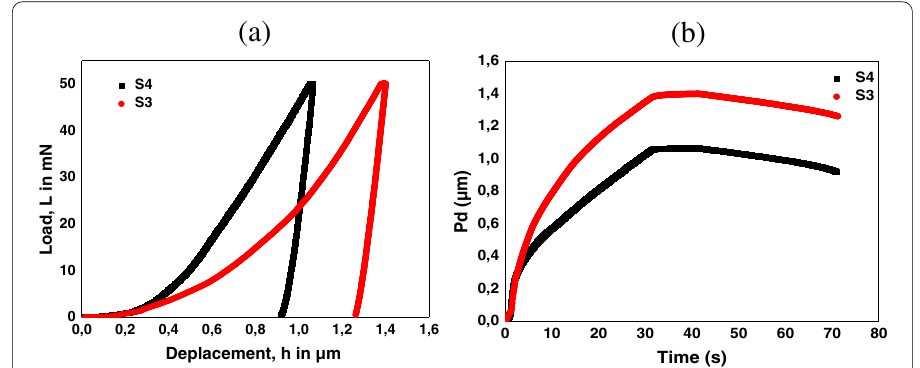
Fig. 8 a Displacement curves obtained by CSM mode in nano-indentation and b the depth of penetration as a function of time